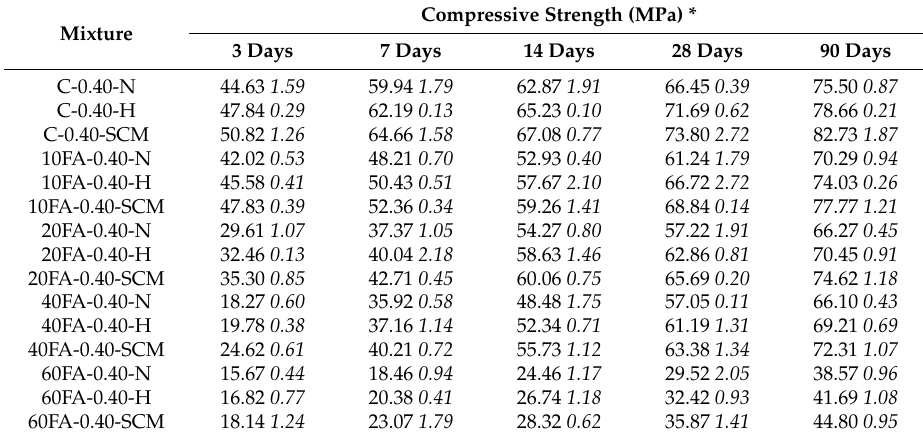
Table A2. Compressive strength for w/b